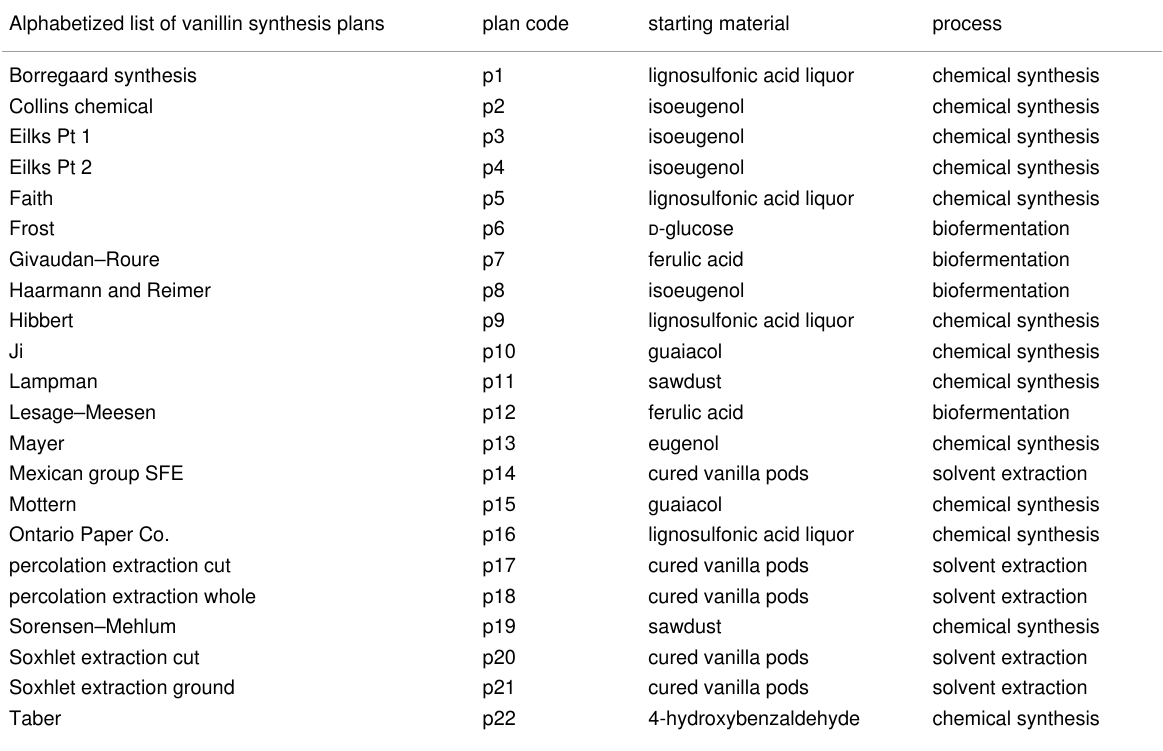
Table 2: Summary of plan codes, starting materials, and process types for 22 synthesis plans of vanillin.